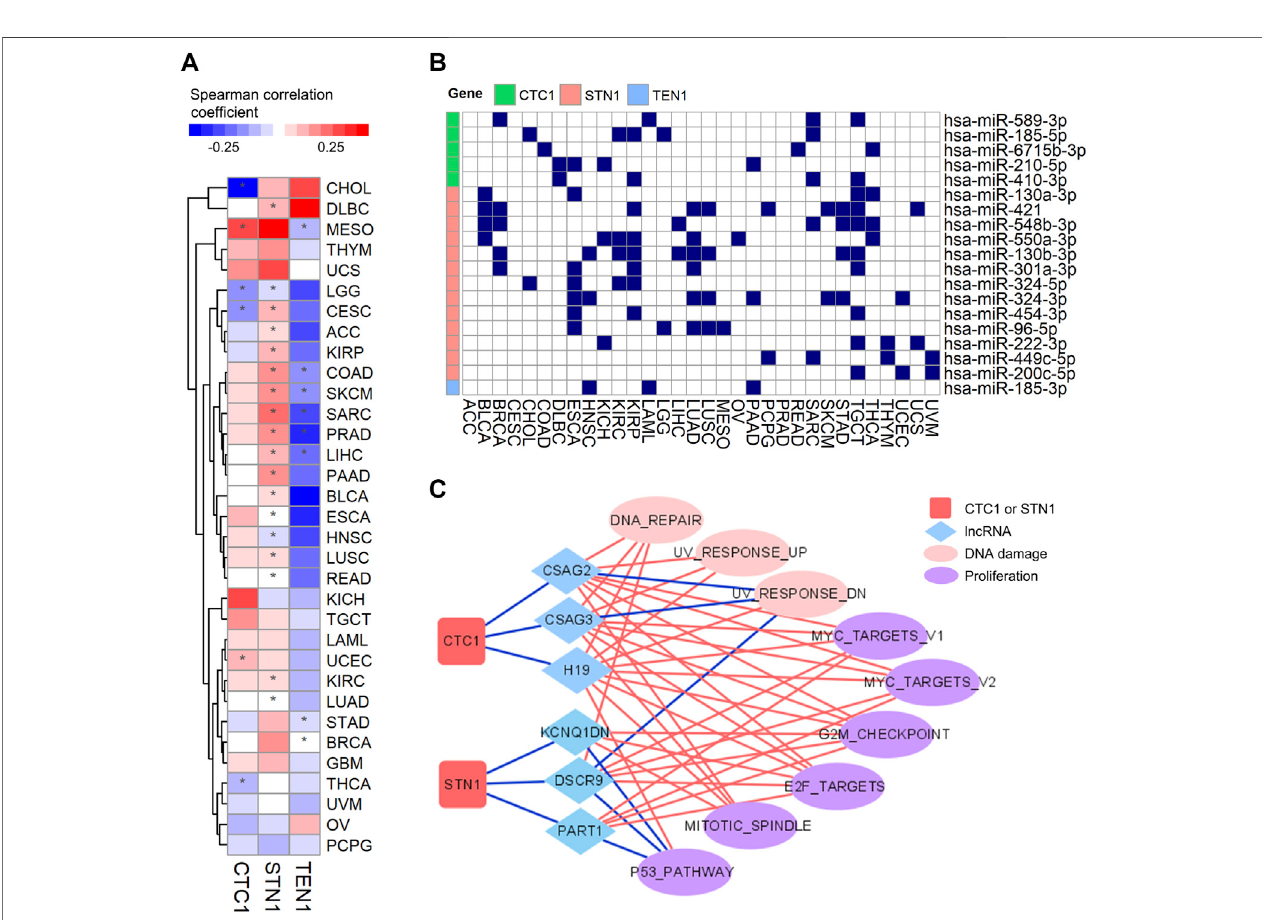
FIGURE 6 | Regulations of expression of the CST complex by DNA methylation, lncRNA, and miRNA: (A) heatmap shows Spearman correlation coef fi cient between CST expression and DNA methylation level (beta value) within promoters in each cancer type. Red indicates positive correlation, and blue indicates negative correlation. The * symbol indicates a statistically signi fi cant (* p < 0.05). (B) Graph showing miRNAs and their CST targets in multiple tumor types. The blue rectangle indicates that miRNA interacts with its targets. (C) Connective network among CTC1, STN1, lncRNA, and pathways. The red line indicates positive connection, while the blue line indicates negative connection.